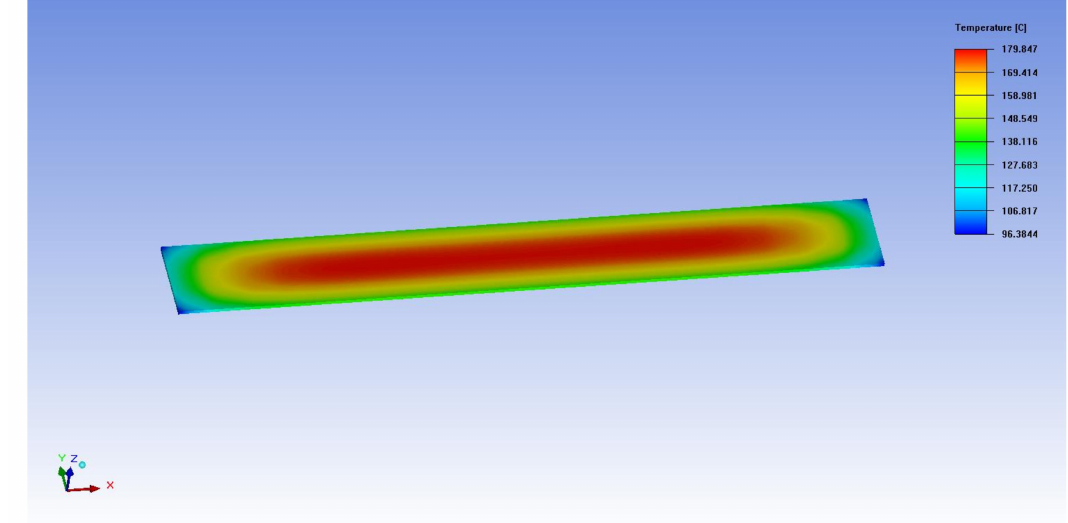
Figure A1. Calculation result of the thermal conductivity.